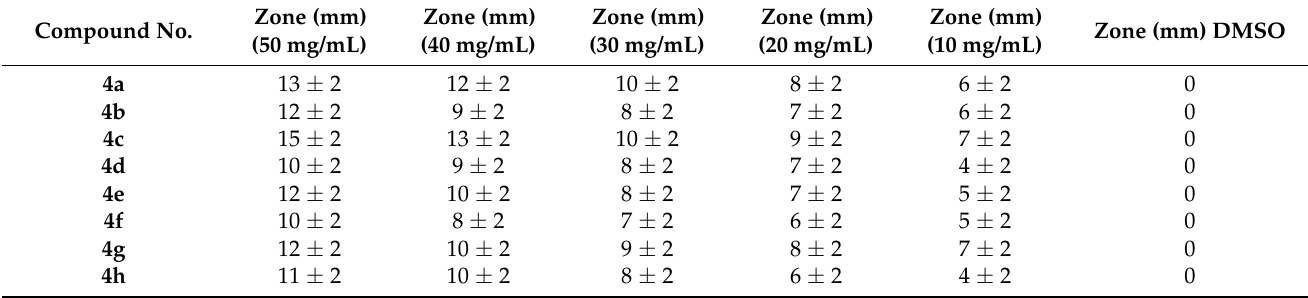
Table 2. Agar well diffusion of compounds ( 4a – h ) against ESBL-producing E. coli